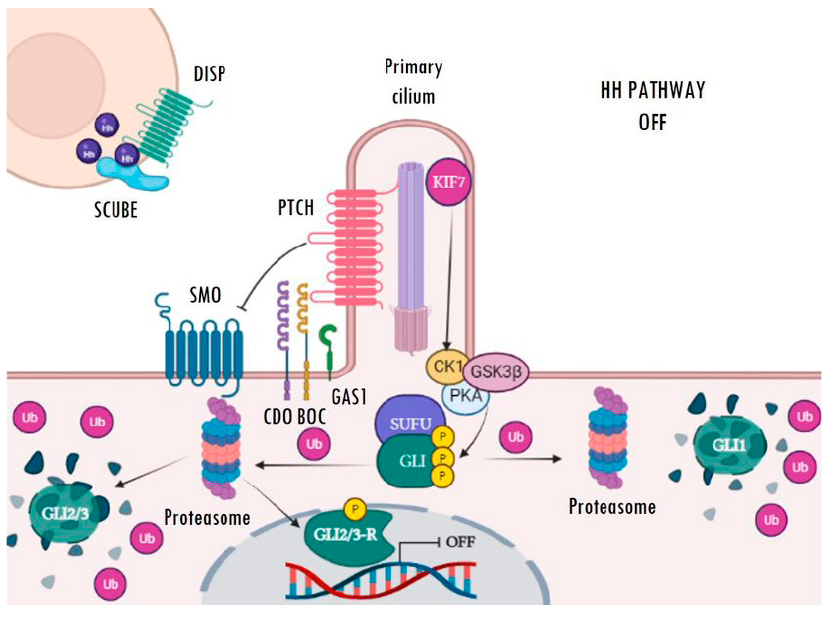
Figure 1. Inactive Hedgehog signalling. In the absence of Hh ligands, PTCH blocks the ciliary localization of SMO. The GLI transcription factors, located at the base of the primary cilium, are inhibited by the SUFU repressor complex. Then, KIF7 mediates GLI phosphorylation via PKA, CK1, and GSK3B kinases. Phosphorylated GLI1 is then ubiquitinated and totally degraded by the proteasome. However, GLI2 and GLI3 can be entirely or partially degraded. Incomplete degradation of GLI2/3 gives rise to the GLI repressor forms (GLI-R), which are translocated to the nucleus and inhibit the transcription of target genes. Image created with BioRender (BioRender.com).